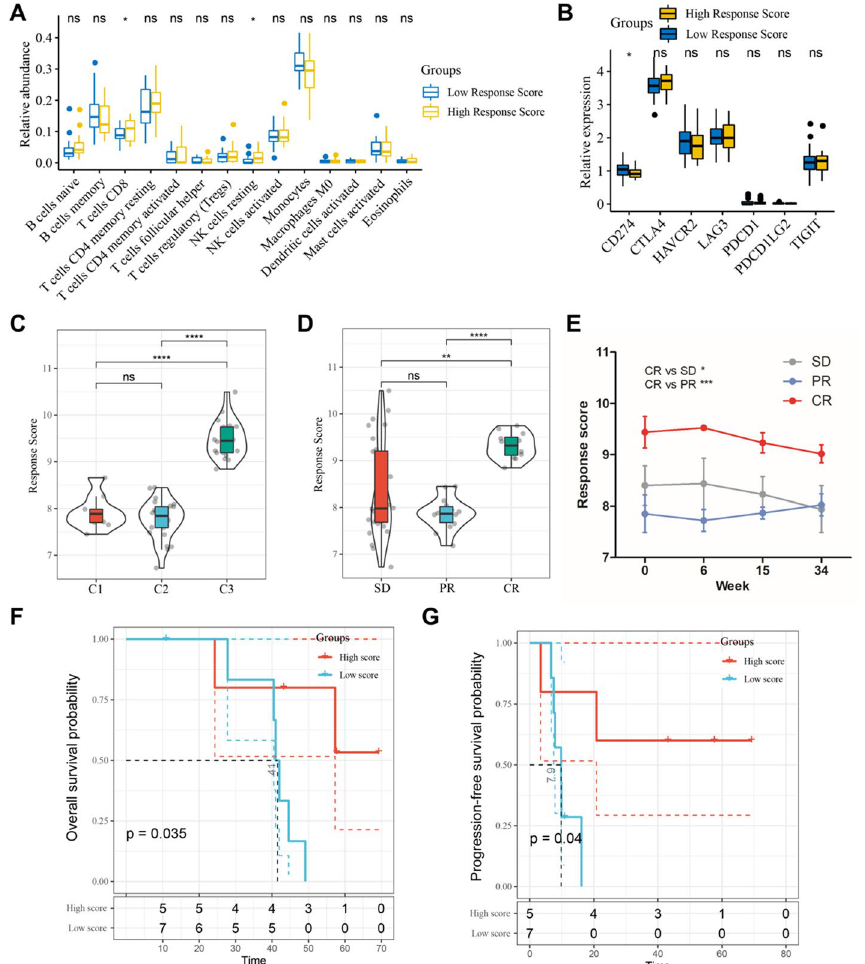
Fig. 5 RRG-related Response Score in LGG. a The relative abundance of each circulating immune cells in high- and low-Response Score groups. The upper and lower ends of the boxes represented interquartile range of values. The lines in the boxes represented median value, and dots showed outliers. b Immune-checkpoint-relevant genes (CD274, CTLA4, HAVCR2, LAG3, PDCD1, PDCD1LG2, and TIGIT) expressed in high- and low-Response Score groups. Within each cluster, the upper and lower ends of the boxes represented interquartile range of values. The lines in the boxes represented median value, and black dots showed outliers. c Differences in Response Score between Cluster 1, Cluster 2, and Cluster 3. The differences between every two groups were compared through the Kruskal–Wallis test. d Differences in Response Score between SD, PR, and CR samples. The differences between every two groups were compared through the Kruskal–Wallis test. e Average ( SD) value of RRG-related Response Score (y axis) from week 0 to 34 (x ± axis). Response groups are indicated by color. f , g Kaplan–Meier curves for OS ( f ) and PFS ( g ) showing the difference in survival between high-Response Score group and low-Response Score group (log-rank test, p < 0.05). High-Response Score group is indicated in red line and low-Response Score group in blue. * P < 0.05, ** P < 0.01, *** P < 0.001, **** P <